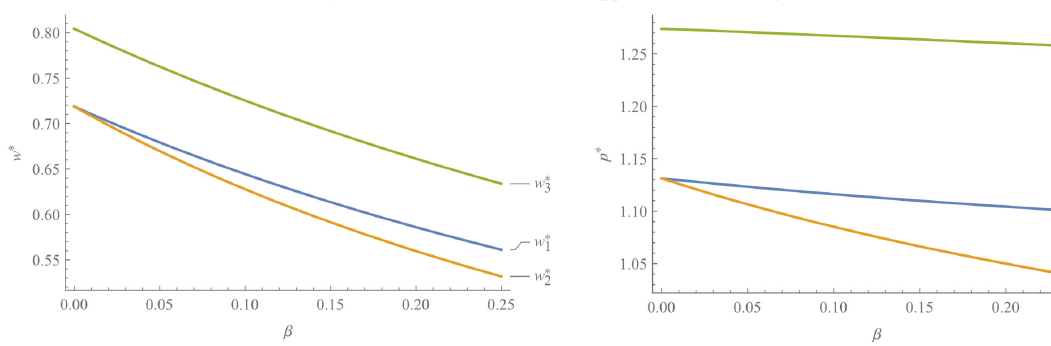
Fig. 7. The impact of the manufacturer's risk aversion on the wholesale price